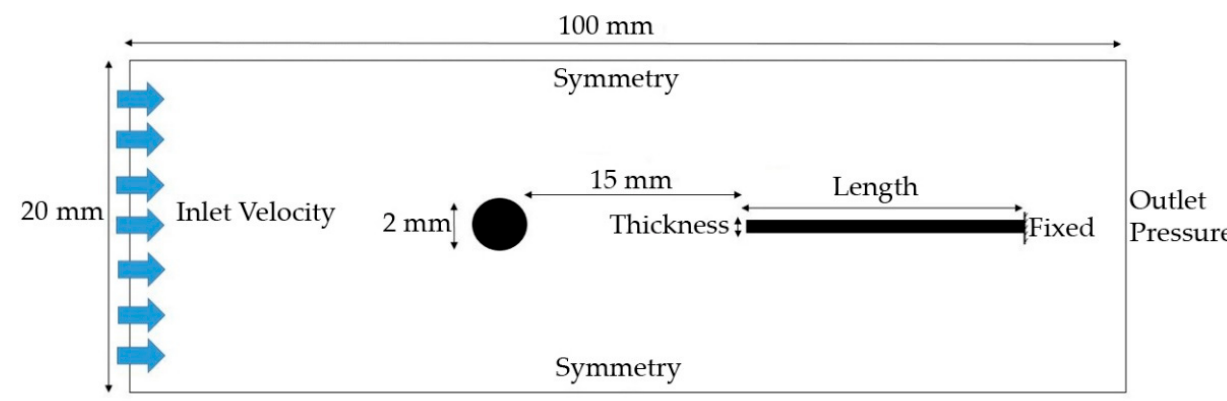
Figure 2. Schematic of piezoelectric energy harvester (PEH) structure.